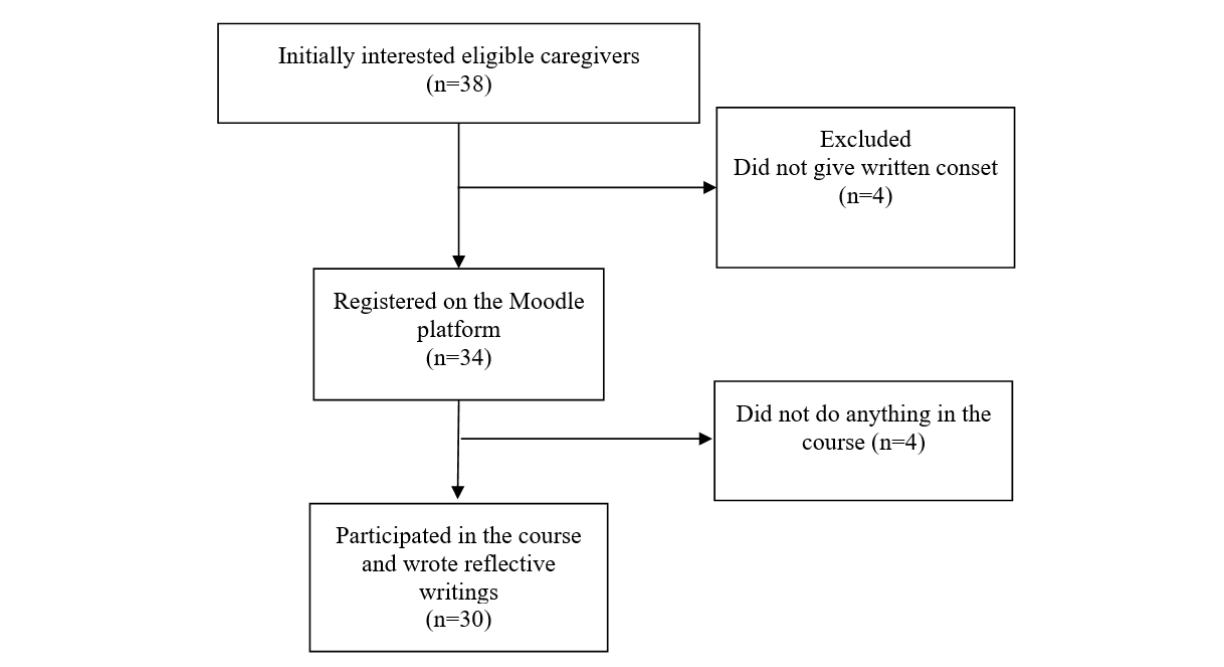
Figure 1. Flow diagram of the